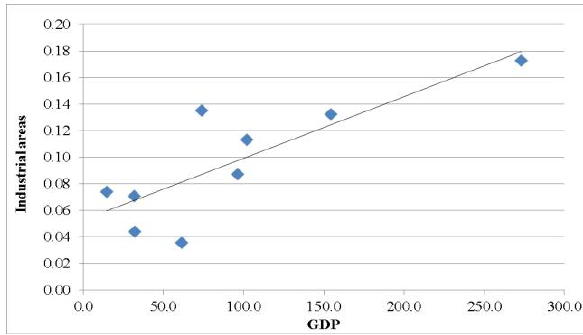
Figure 17. Relationship between the percentage of built-up areas and total employment without Edmonton and Victoria City for 2010 ( R 2 = 0.87)